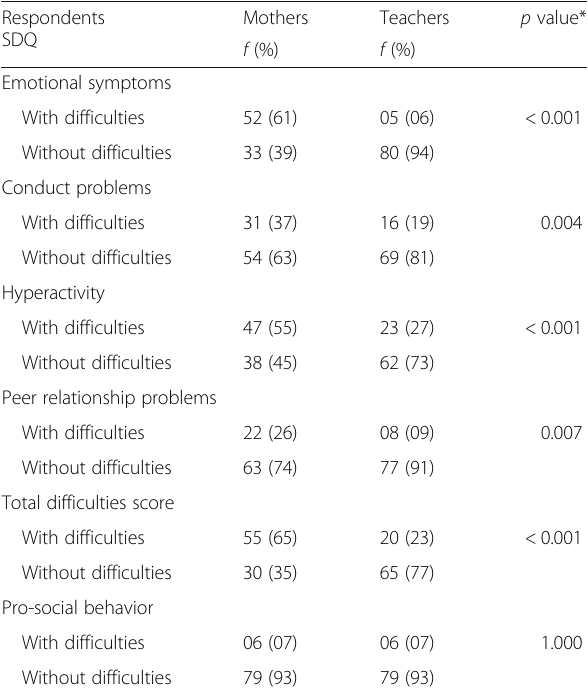
Table 1 Comparisons regarding the behavioral profile of children (SDQ — mothers and teachers) ( n =